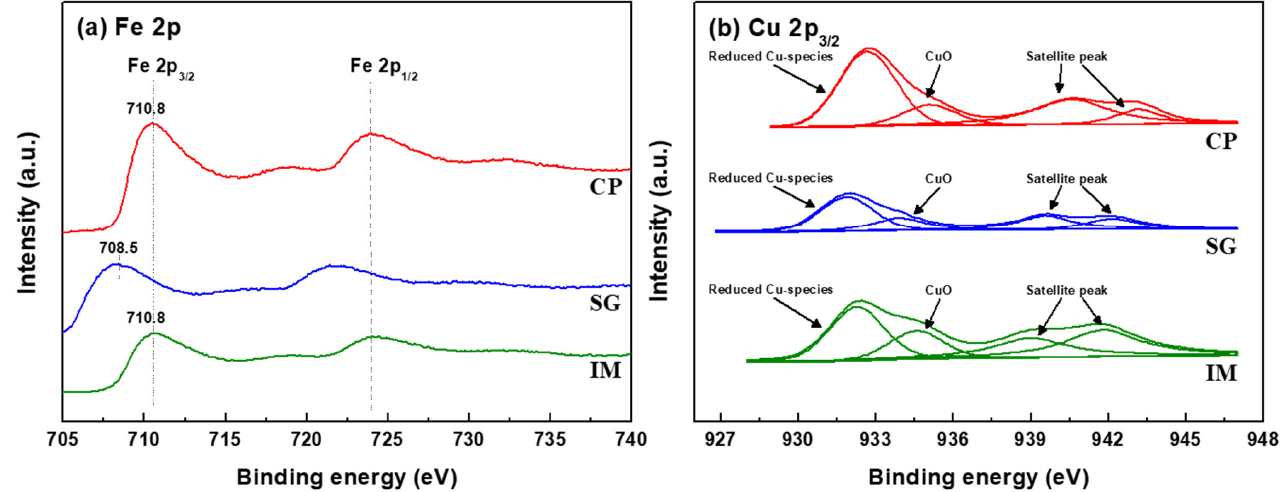
Figure 2. XPS spectra of the fresh FAC catalysts prepared by different methods. ( a ) Fe 2p; ( b ) Cu 2p. Adapted from Ref. [11]. Copyright 2015 Elsevier.